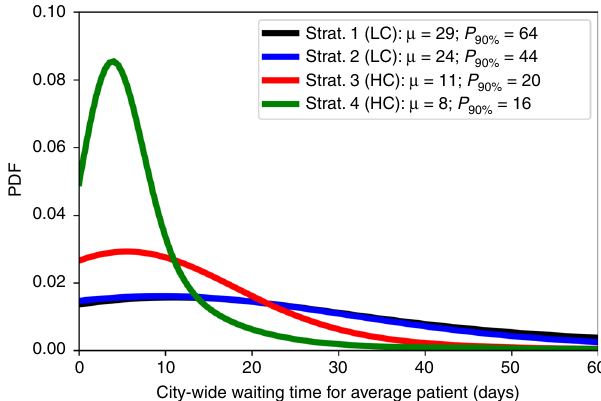
Fig. 5 Distribution of city-wide average waiting time for treatment after the earthquake according to different emergency response plans, highlighting mean ( μ ) and 90th-percentile values ( P 90% ). The time is measured from when the patient is injured by the earthquake until he or she is treated in an operating room. Strategies 1 and 2 are baselines with limited coordination (LC) capacities, whereas strategies 3 and 4 introduce higher coordination (HC) capacities across the whole system level for resource allocation and patient transfers. The ambulance usage and the treatment spatial distribution are show in Fig. 6 for each plan. Source data are provided as a Source Data fi le, and the base map layer is available under a https://www.openstreetmap.org/copyright Open Database Licence (© OpenStreetMap